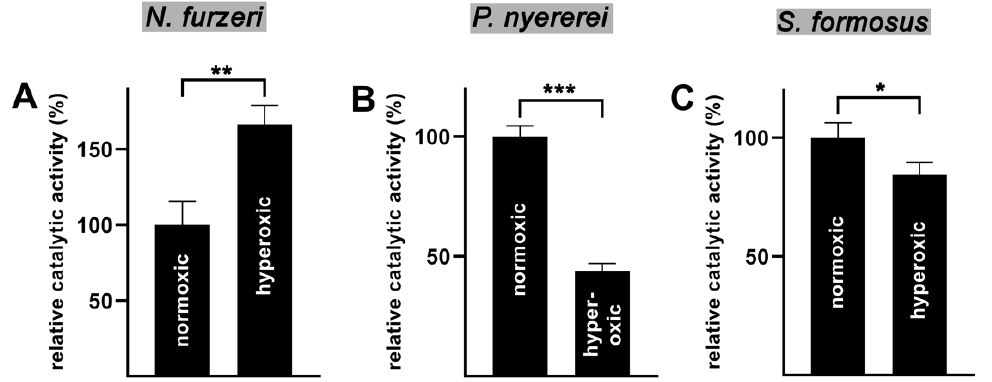
Figure 7. Oxygen dependence of AA oxygenation catalyzed by the three bony fish ALOX isoforms. Activity assays were carried out under normoxic and hyperoxic conditions and the formation of specific ALOX products during the incubation period (3 min) was quantified by RP-HPLC. Three independent measurements were carried out for each enzyme at either condition. The mean of product formation under normoxic conditions for each enzyme was set 100% and the relative oxygenase activities were calculated. Experimental raw data were evaluated using the two-sided t -test. ( A ) N. furzeri, ( B ) P. nyererei , ( C ) S. formosus . The asterixis above the columns indicate the degree of statistical significance (* p < 0.05, ** p < 0.01, *** p < 0.001, t -test).